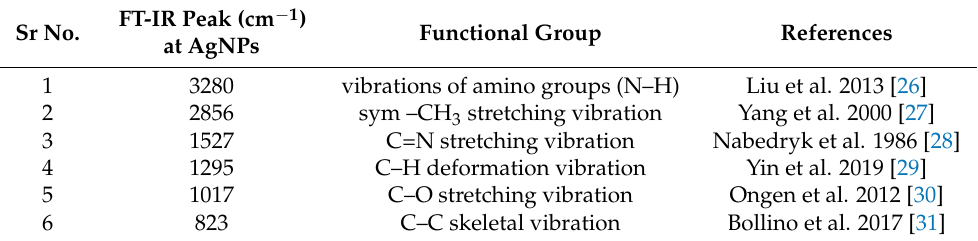
Table 4. FT-IR analysis of